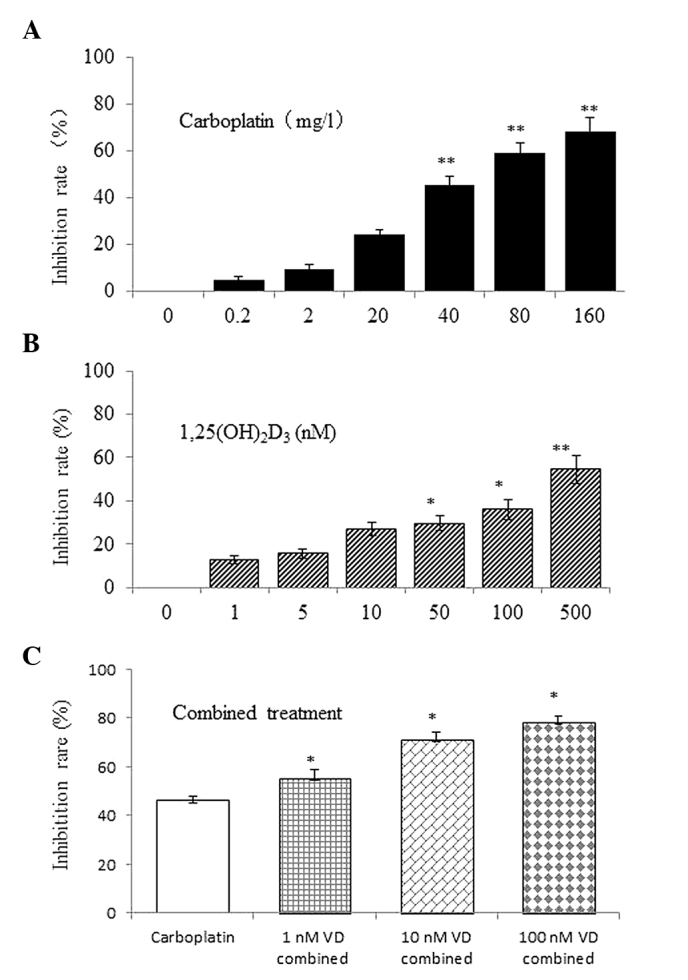
1,25(OH)2D3 and/or carboplatin inhibition of SKOV-3 cell growth. Growth inhibition increased with increasing doses of (A) carboplatin and (B) 1,25(OH)2D3 over 72 h. *P<0.05 and **P<0.01, vs. the vehicle control. (C) Growth inhibition also increased with combined 1,25(OH)2D3 and carboplatin treatment. *P<0.05, vs. single-drug treatment. 1,25(OH)2D3, 1,25-dihydroxyvitamin D3.